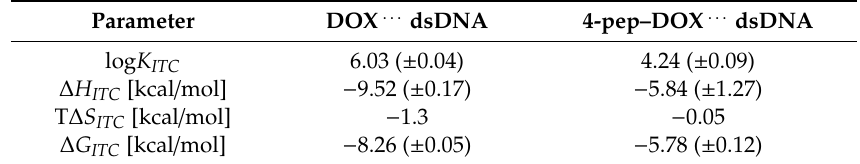
Figure 9. Calorimetric titration isotherms of the binding interaction between ( A ) DOX and dsDNA and between ( B ) 4-pep–DOX and dsDNA in 10 mM Tris-HCl buffer (pH 7.2, 25 °C). Table 1. Thermodynamic parameters of DOX and 4-pep–DOX bound to dsDNA in 10 mM Tris-HCl bu ff er (pH 7.2) at 25 ◦ C (standard deviation values in parentheses). ITC, isothermal titration